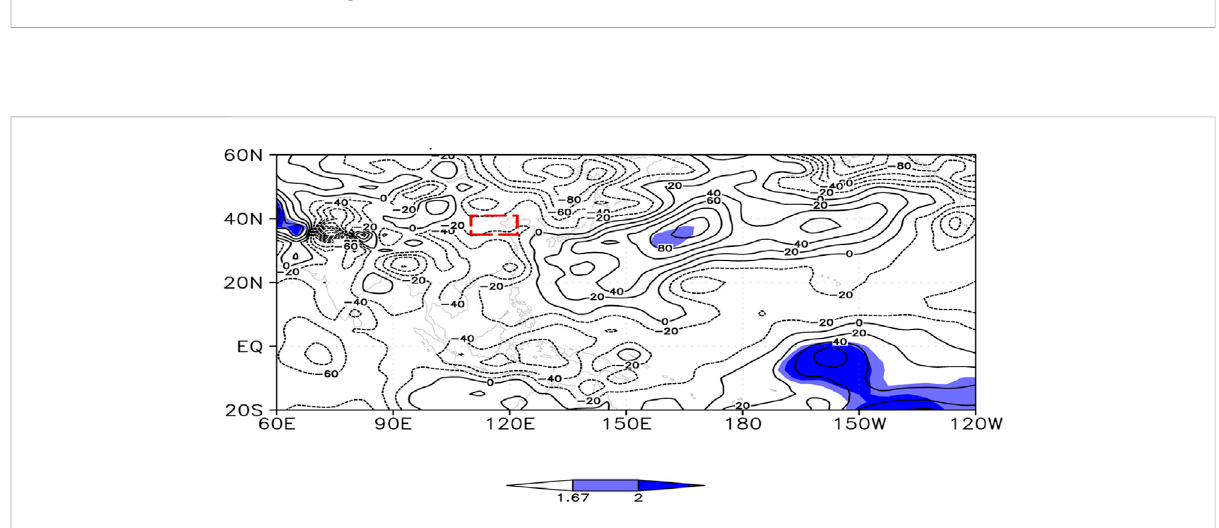
FIGURE 11 ThesameasFigure3butforsealevelpressure(unit:hPa).Shadedareasshowthedifferencereaching90%and95%con fi dencelevelsaccording to Student ’ s t -test. The box shows the region of North